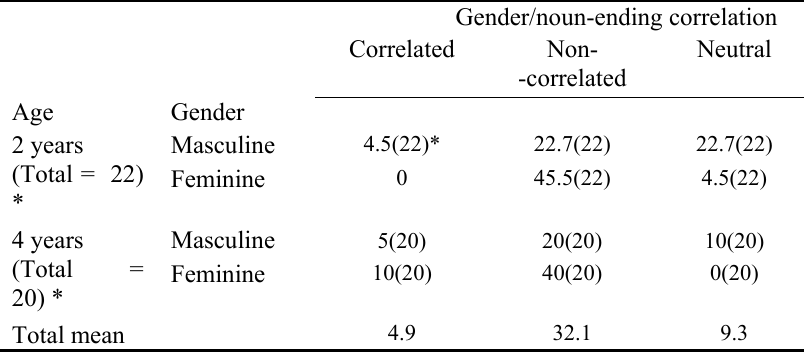
Table V: Percentage target responses with noun-ending alterations in